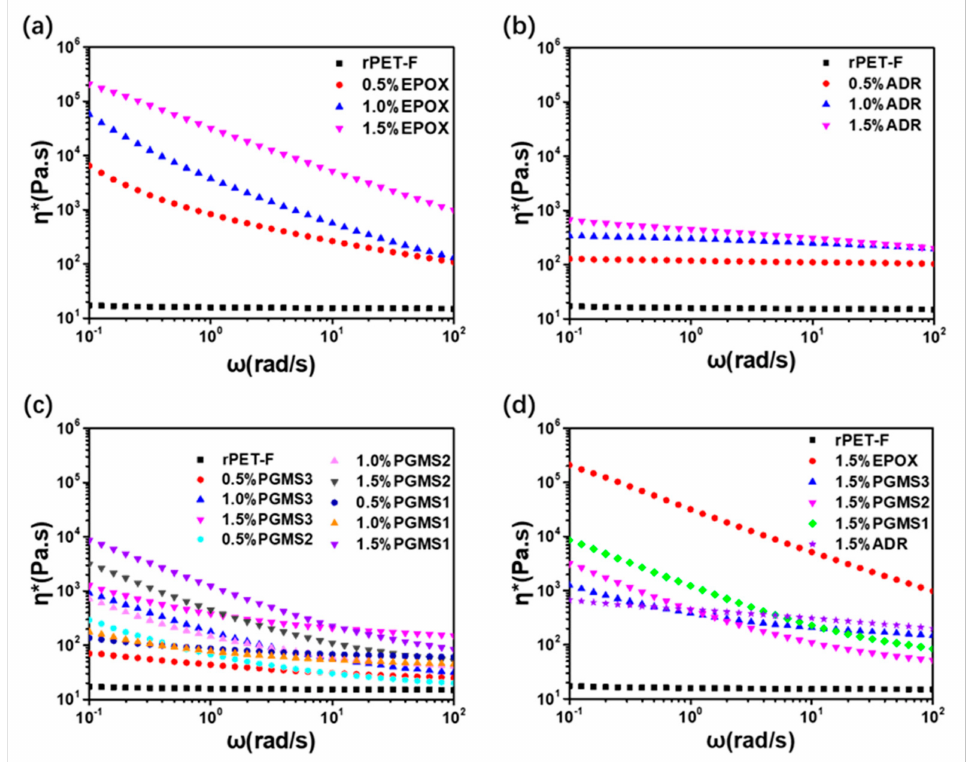
Figure 5. Complex viscosity ( η *) vs. angular frequency ( ω ) for various modified PETs by ( a ) EPOX, ( b ) ADR-4468, ( c ) PGMSx and ( d ) different chain extender at in the same